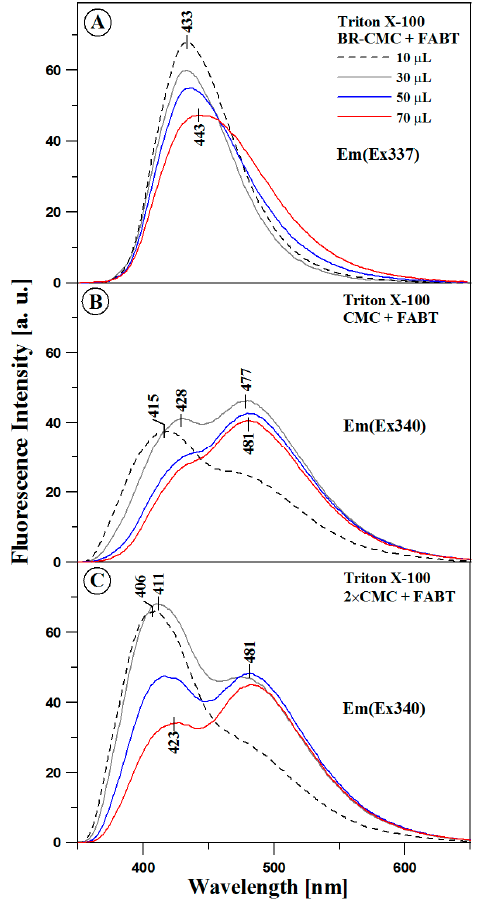
Figure 3. FABT fluorescence emission spectra corresponding to various concentrations of Triton X-100 per 3 mL of the buffer with subsequently titrated amounts of FABT at the concentration of c = 3 × 10 − 3 M. The spectra correspond to the measurements presented in Figure 2 and Figures S5 and S6 in Supplementary Materials. Panel ( A ) presents the results of the experiment conducted for the Triton X-100 in the amount of 10 μ L per 3 mL of the buffer (BR-CMC), Panel ( B ) for 50 μ L (CMC) of and Panel ( C ) for 100 μ L (2× CMC) of the detergent. The symbol Em(Ex337/340) stands for excitation and emission at the corresponding wavelength, the rest analogically. The spectra were recorded at the temperature of 22 °C.